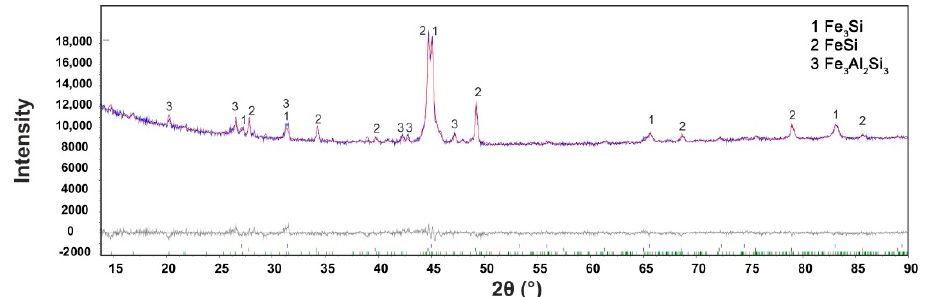
Figure 2. Rietveld plot of FeAl20Si20 alloy produced by mechanical alloying and spark plasma sintering. The amount of Fe 3 Si phase (Fm3m) was determined as 33.0 wt %. The lattice parameter